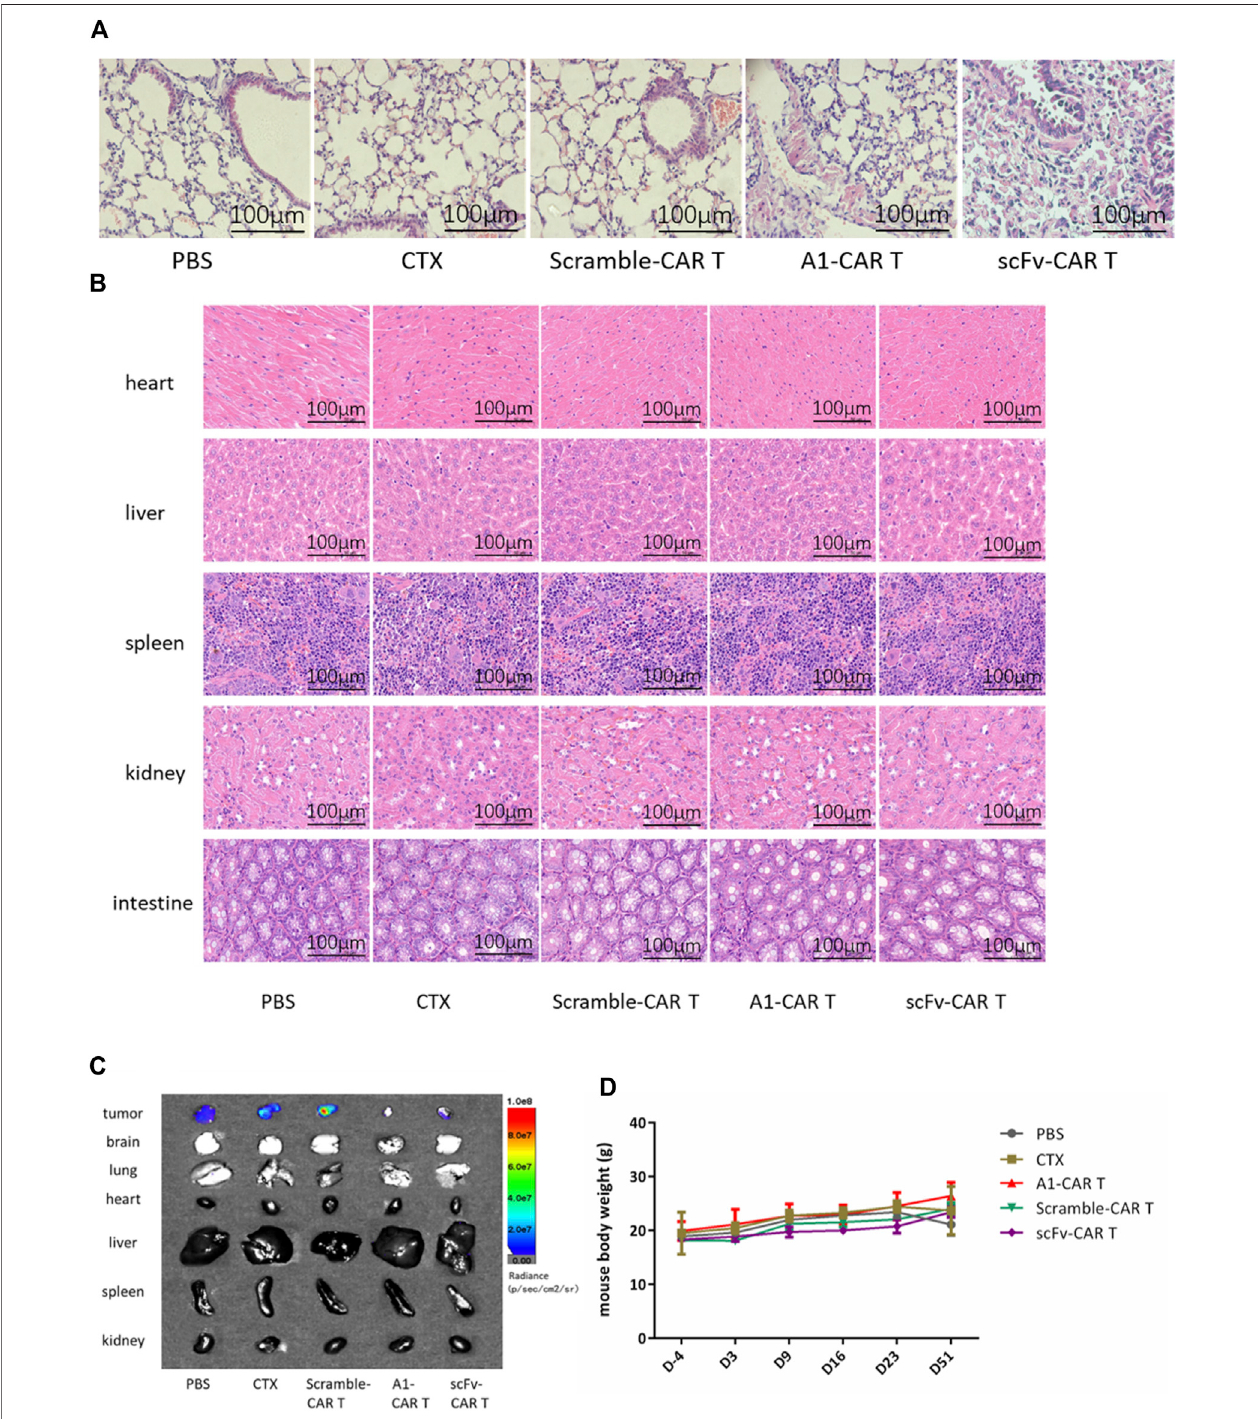
FIGURE5| TreatmentwithA1-CARsreducedon-target,off-tumortoxicity.Onday51,miceweresacri fi cedafter5 minutes. (A) LungtissuewasstainedwithH&E. (B) Heart, liver, spleen, kidney and intestine tissue wasstained with H&E. (C) On day 51, mice were injected i. p. with D-Luciferin potassium salt and were sacri fi ced after 5 minutes. Tumor tissues and organs (lung, heart, liver, spleen, kidney, brain and intestine)were resected from the mice, and measured the bioluminescence by the IVIS Lumina II system (PerkinElmer). (D) The mice body weight was calculated. n = 4 mice. Values represent mean ± SD.